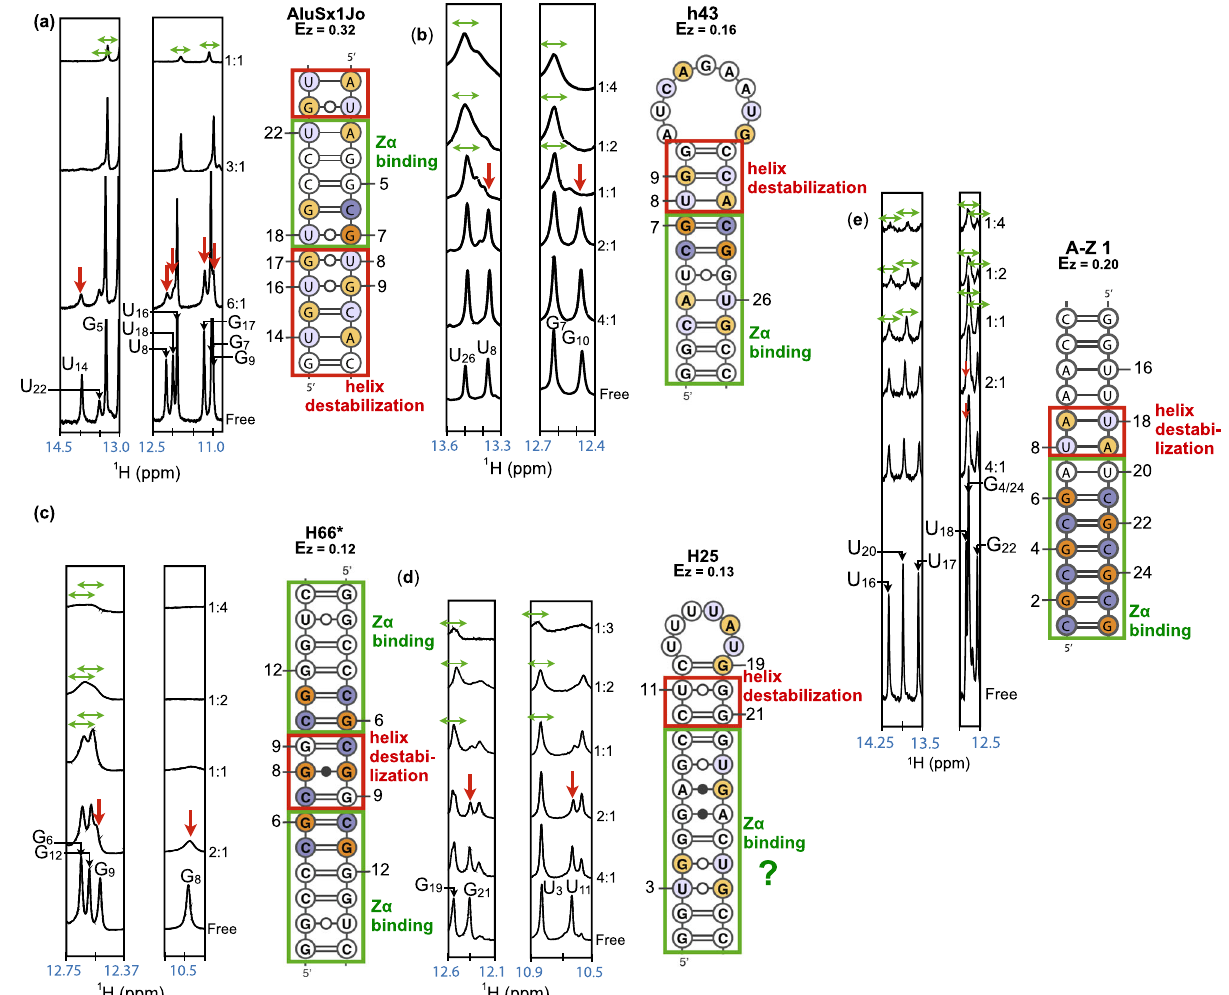
Fig. 3 Pinpointing Z α binding sites and helix destabilization within various RNA sequence contexts. 1 H-1D spectra of the following fragments: a AluSx1Jo, b h43 from E. coli , c H66* (extended duplex) from H. sapiens , d H25 from H. sapiens , e A-Z 1, at decreasing RNA:Z α ratios (right-hand side of the spectra slices). Peak disappearance (vertical red arrows) at low concentrations of Z α (below 1:1) caused by destabilization of the A-form helix required for A-Z junction formation is shown. Further line broadening at higher stoichiometric ratios of Z α to RNA (1:1, 1:2, 1:3, 1:4 RNA:Z α ) indicate further binding of Z α proteins and growing complex size (green horizontal arrows). Full imino spectra are shown in Supplementary Fig. 8. For H25, due to the lack of information on the imino protons of G 6 and G 24 , in addition to being unable to determine whether G4 is destabilized or coalesces with G28, the exact Z α binding region cannot be con fi rmed. NMR measurements were performed once as customary, and showed consistency with CD, ITC, and